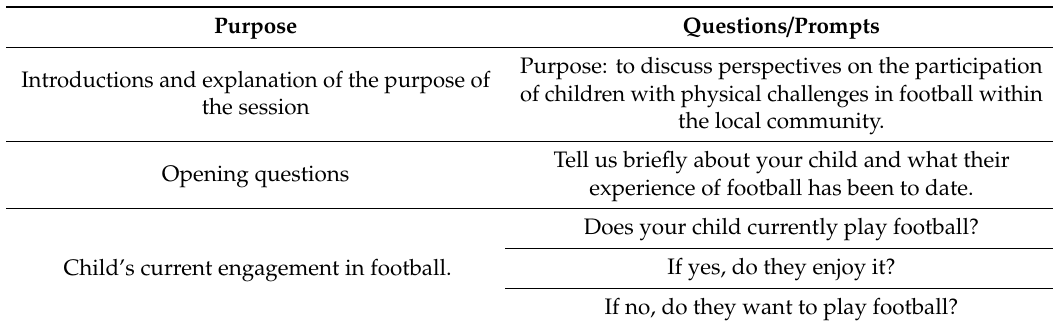
Table A2. Parent focus group